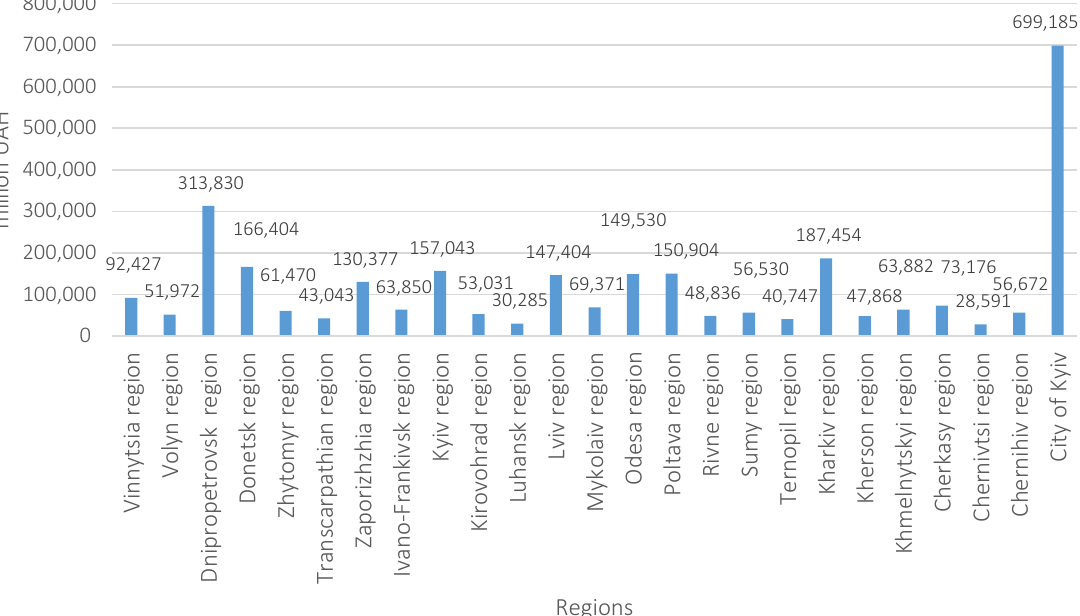
Figure 1. Gross regional product by regions of Ukraine in 2017, in actual prices, million UAH